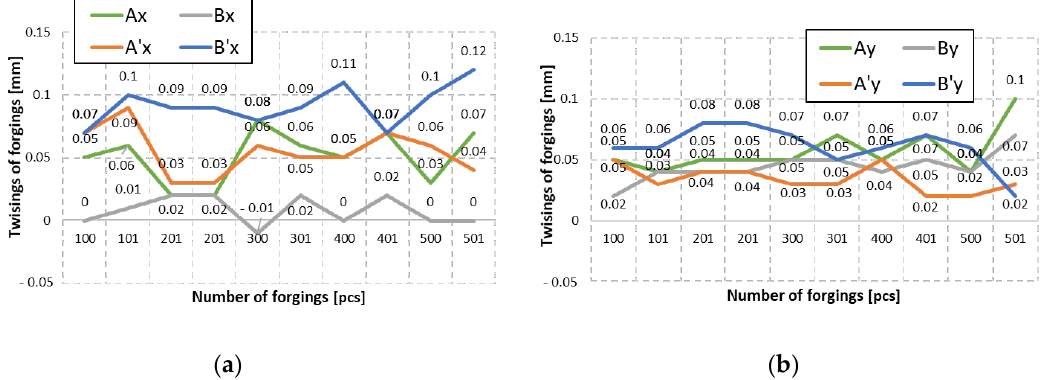
( b ) Figure 19. Concept of geometrical changes shown on a schematic diagram of the upper cassette SMED system: ( a ) the working space of the press, ( b ) introduced changes (the original arrangement/orientation of keyways are schematically marked in blue).